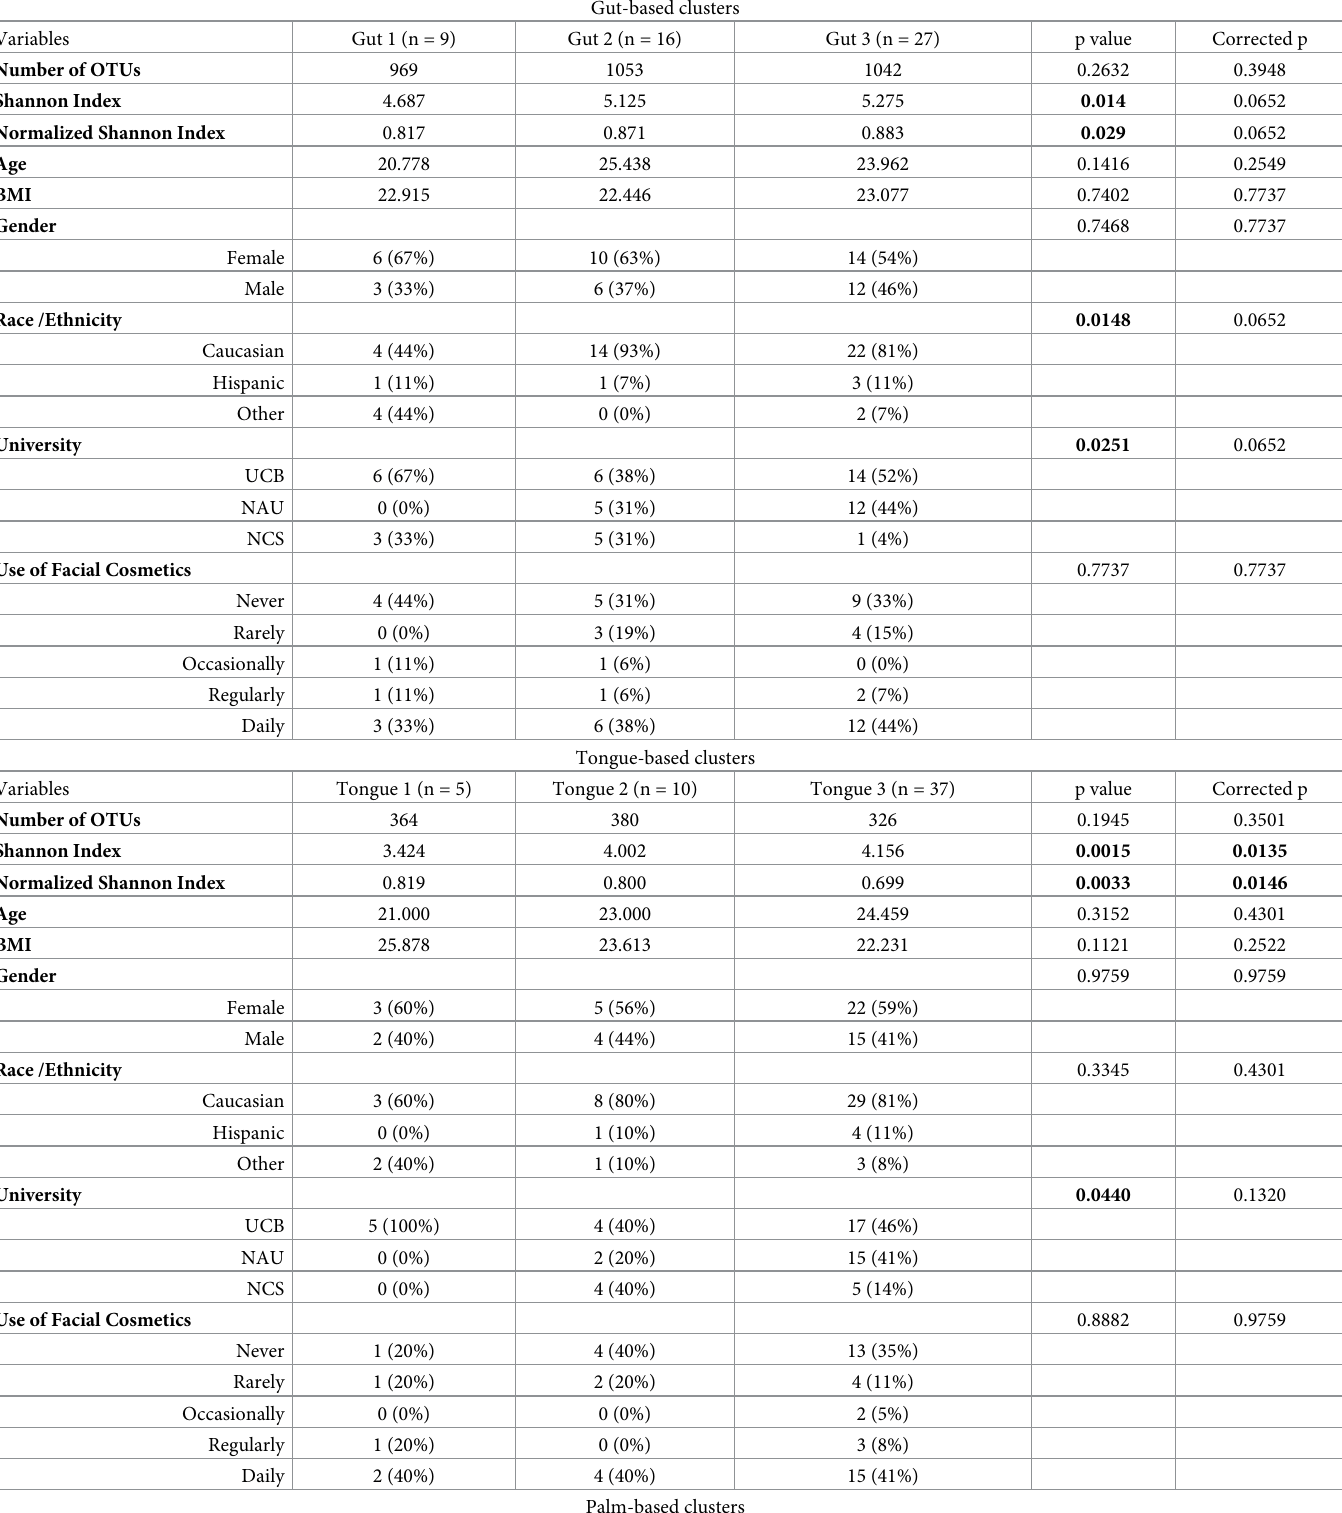
Table 4. Overall microbiome, demographic, and behavioral data for each of the identified clusters based on dynamics of a) gut microbiome, b)tongue microbiome, c)palm microbiome, d)forehead microbiome, e) four sites microbiome. Gut-based